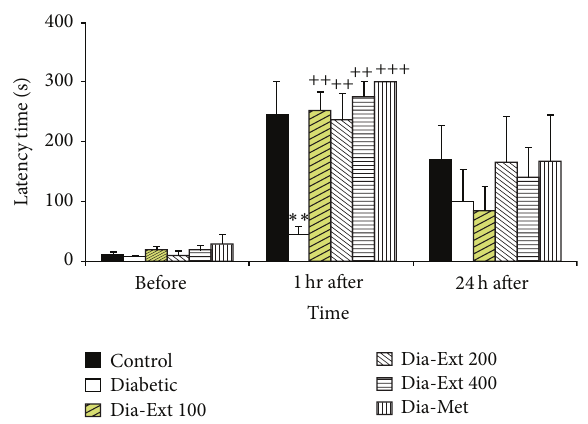
Figure 3: Comparison of the total time spent in the light com- partment before and at 1 and 24 h after receiving the shock in the experimental groups. Data are presented as mean ± SEM ( 𝑛 = 10 in each group). ∗ 𝑃 < 0.05 in comparison with Control group and + 𝑃 < 0.05 in comparison with Diabetic group.